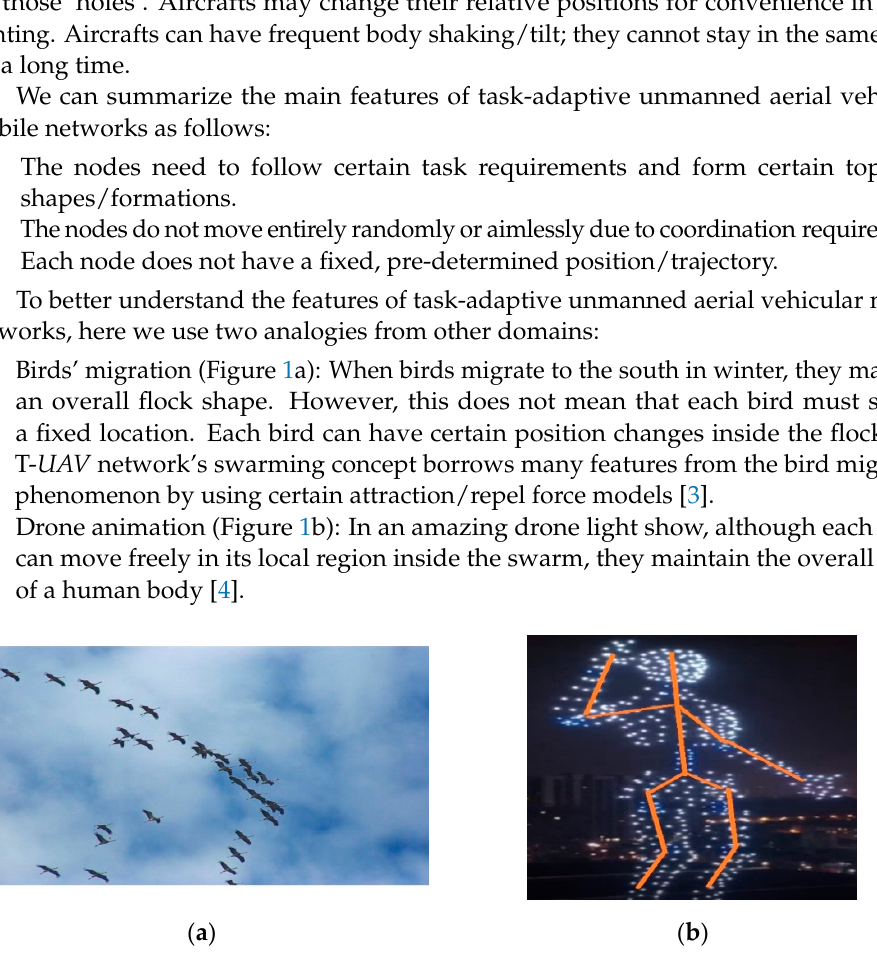
Figure 1. Two task-driven systems with certain network shapes: ( a ) birds’ migration; ( b ) drone for- mation.